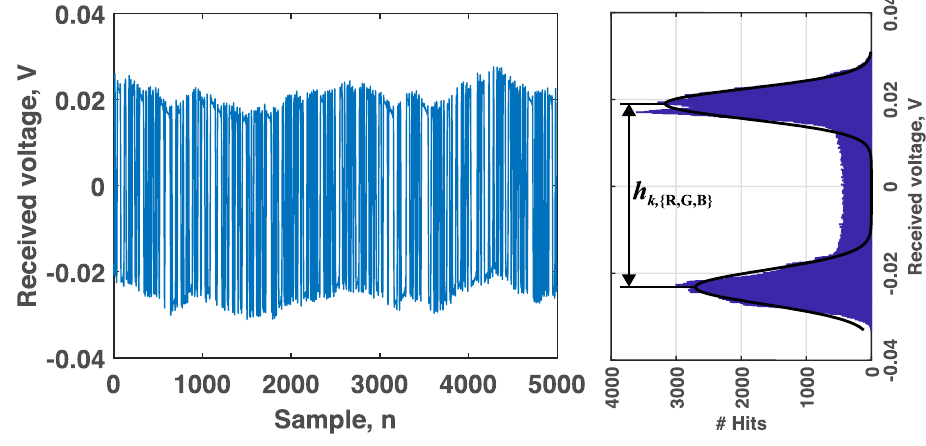
Figure 3. CSI coefficient extraction h k,{R,G,B} from the transmitted pilot signal.